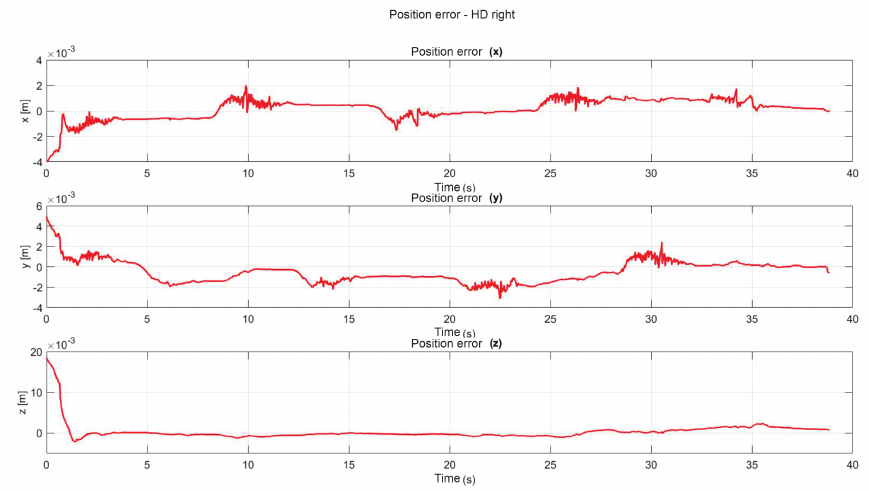
Figure 19. Right haptic device position error: exercise 1.